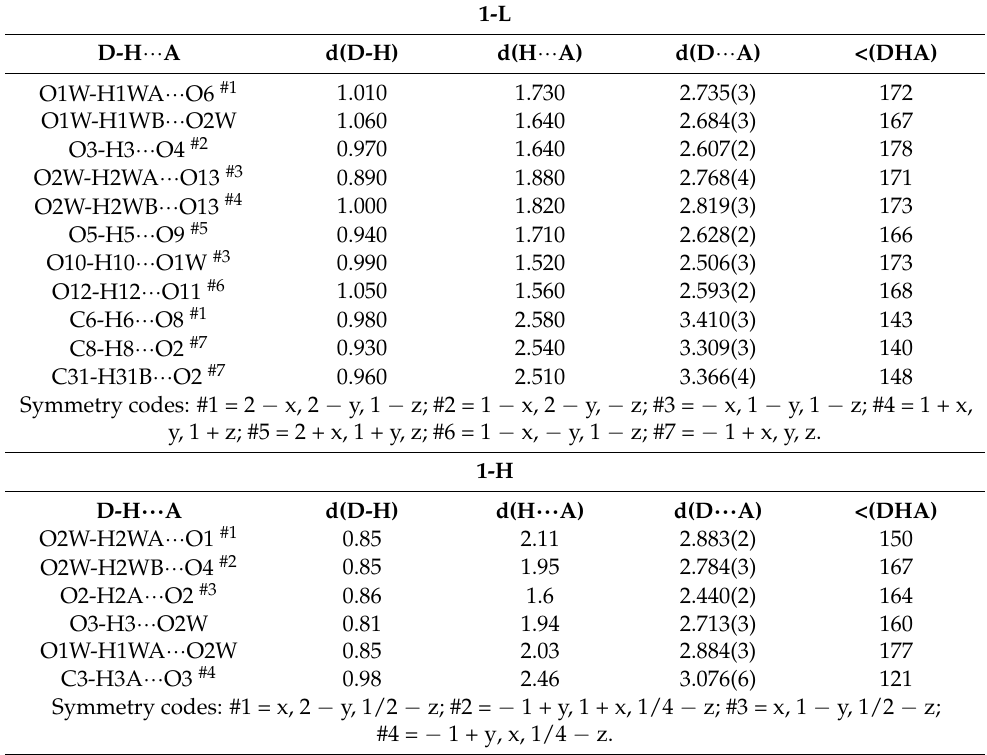
Table 2. Hydrogen bond parameters (Å, ◦ ) in the crystal structures of 1 - L and 1-H